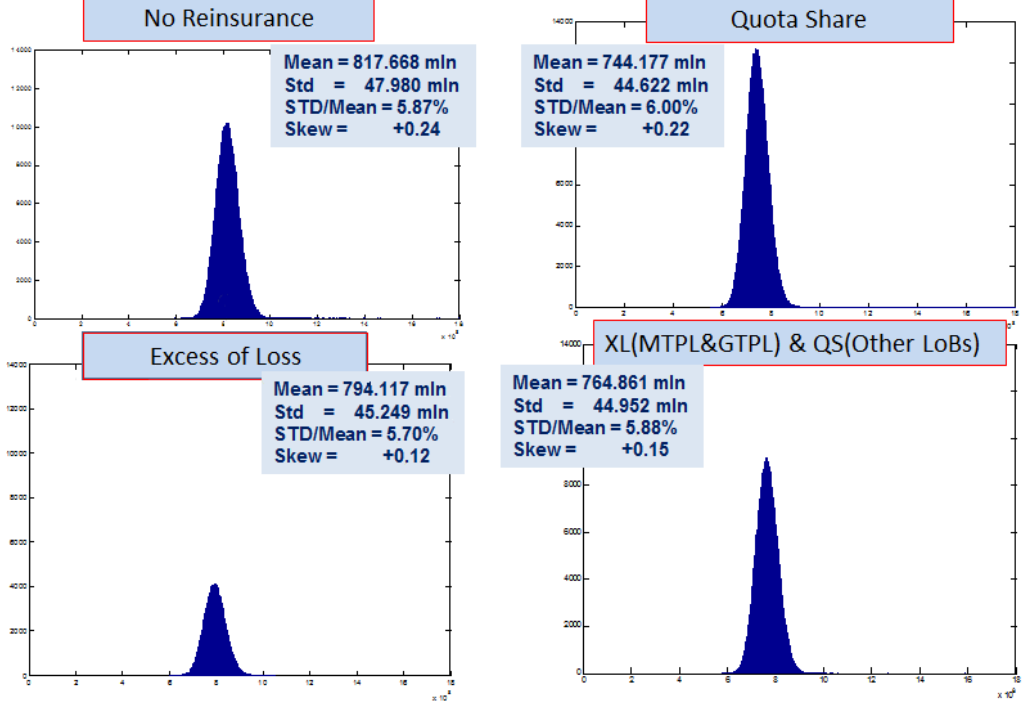
Figure 1. Distribution of aggregate claim amount of Total Portfolio for O MEGA according to different reinsurance